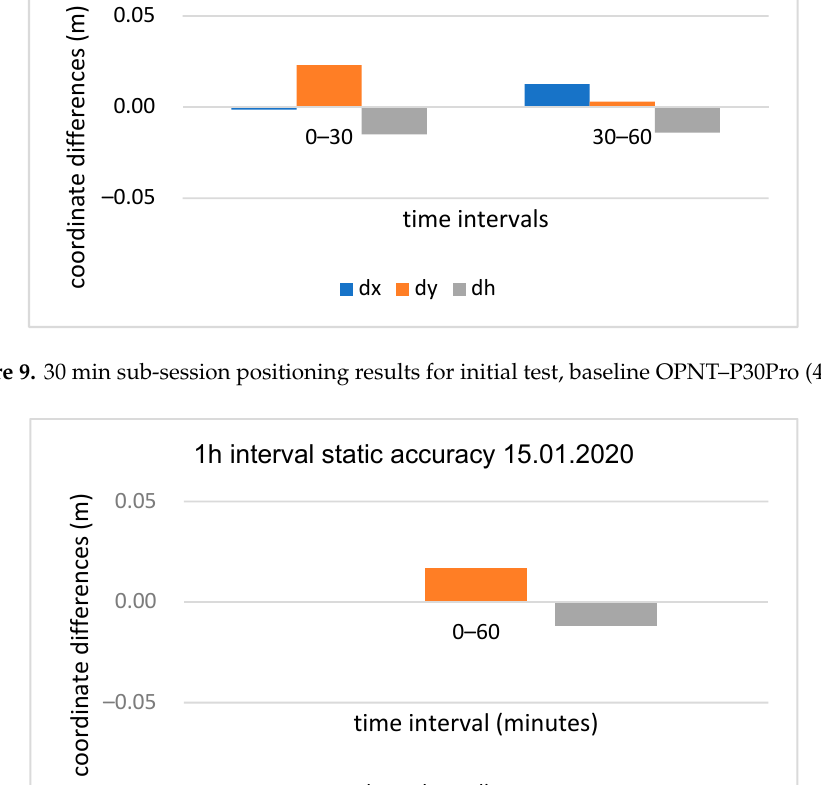
Table 1. 10 min sub-session positioning results summary, baseline OPNT–P30Pro (4 km).